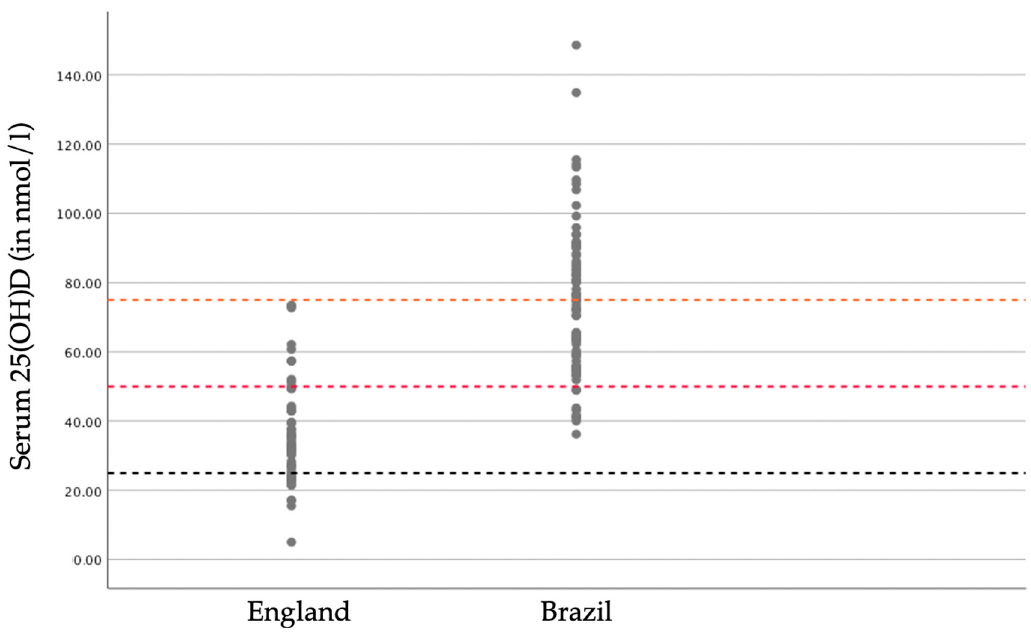
Figure 2. Serum 25(OH)D concentrations for women living in England ( n = 56) and women living in Brazil ( n = 79). Hashed lines represent thresholds of 25 (deficiency), 50 (insufficiency) and 75 (optimal) nmol/L.